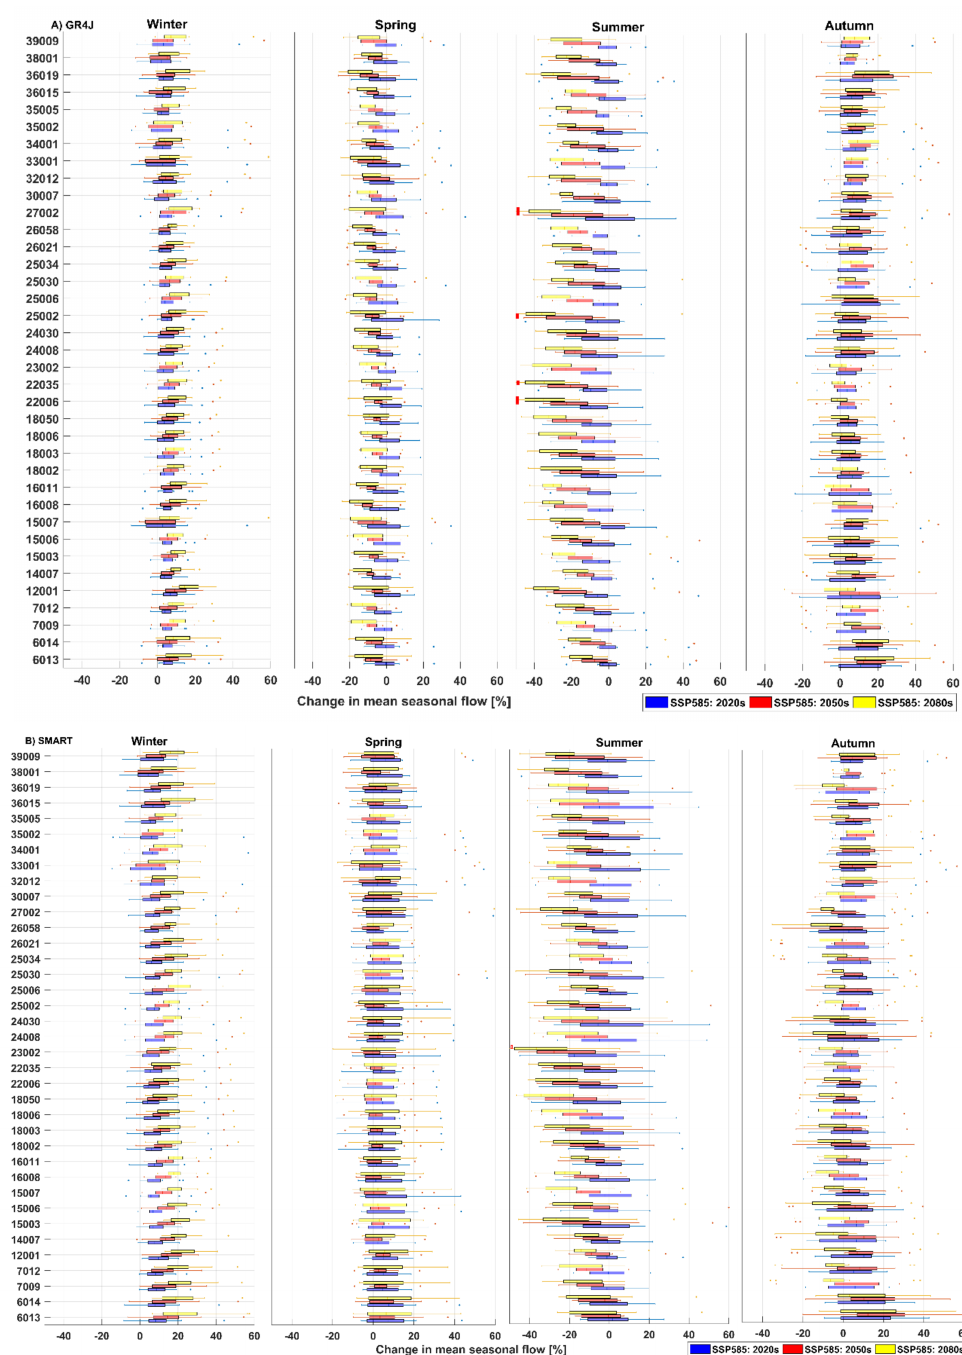
Figure 7. As in Figure 5, but for